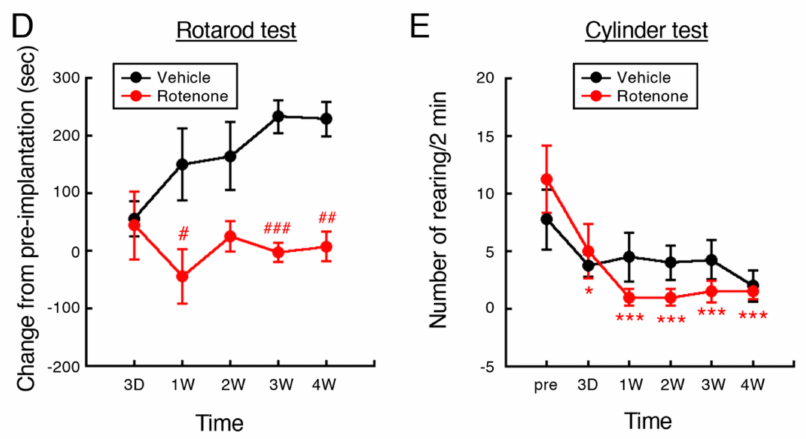
Figure 1. Chronic exposure to low-dose rotenone induced motor deficits in mice. ( A ) Schematic illustrationoftheexperimentalprotocol. MaleC57BL / 6Jmice(8weeksold)wereinjectedsubcutaneously withrotenone(2.5mg / kg / day)for4weeksusinganosmoticminipump. Behavioralassessmentincluding open field, rotarod and cylinder test were performed at 1–6 days before (pre), 1, 3 days, 1, 2, 3, and 4 weeks after implantation of rotenone-filled pump. For immunohistochemistry and mitochondrial complex I activity analysis, tissue samples were collected at 4 weeks after implantation. ( B ) Change in body weight of mice. ( C ) Locomotor activity was assessed as total distance (cm) for 5 min using open field apparatus (50 × 50 × 35 cm). ( D ) Motor function was assessed by fixed-speed rotarod test (24 rpm). Change in time latency (s) from pre-implantation of pump was indicated. ( E ) Number